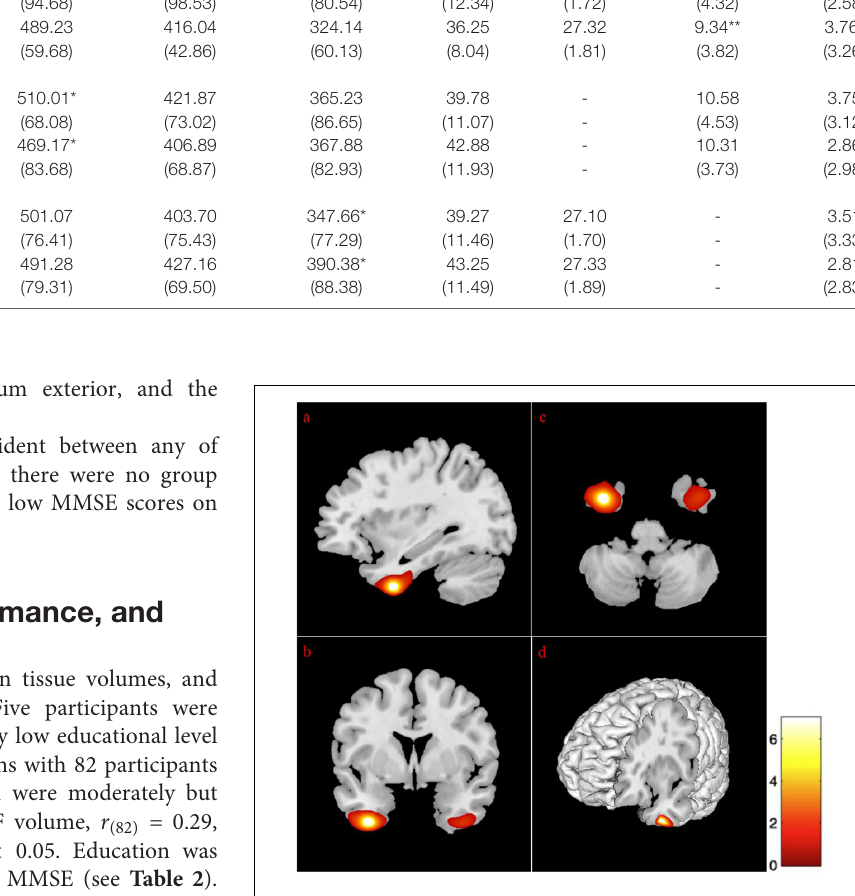
differences were evident for GM, WM, and VBR (for means and standard deviations see Table 3